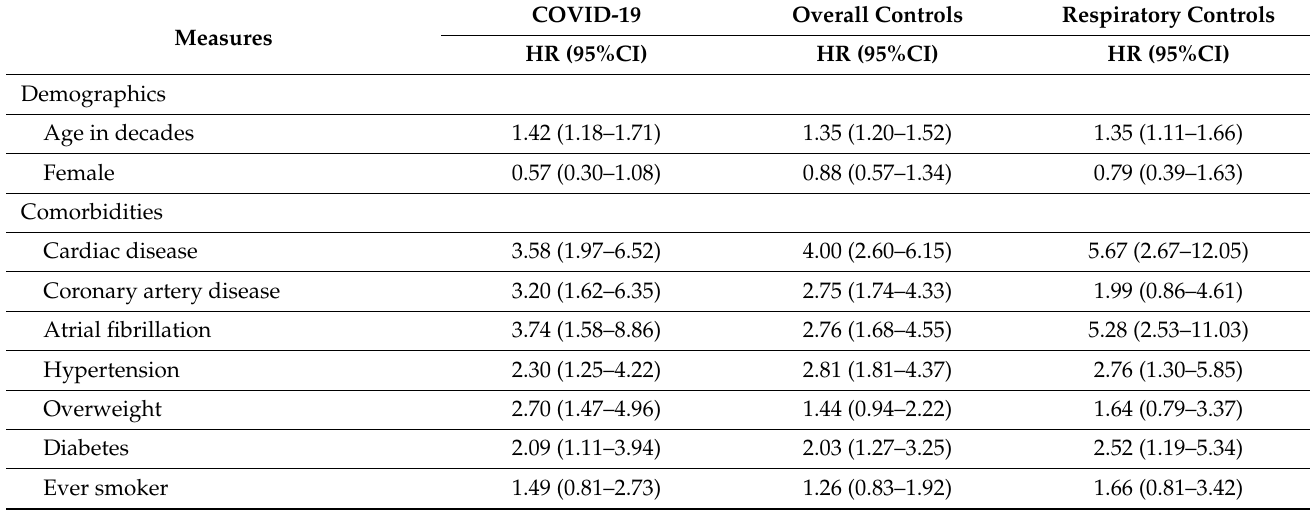
Table 4. Predictive value of clinical parameters at ED presentation for incidence of ICU admission or death at 30 days in COVID-19 and